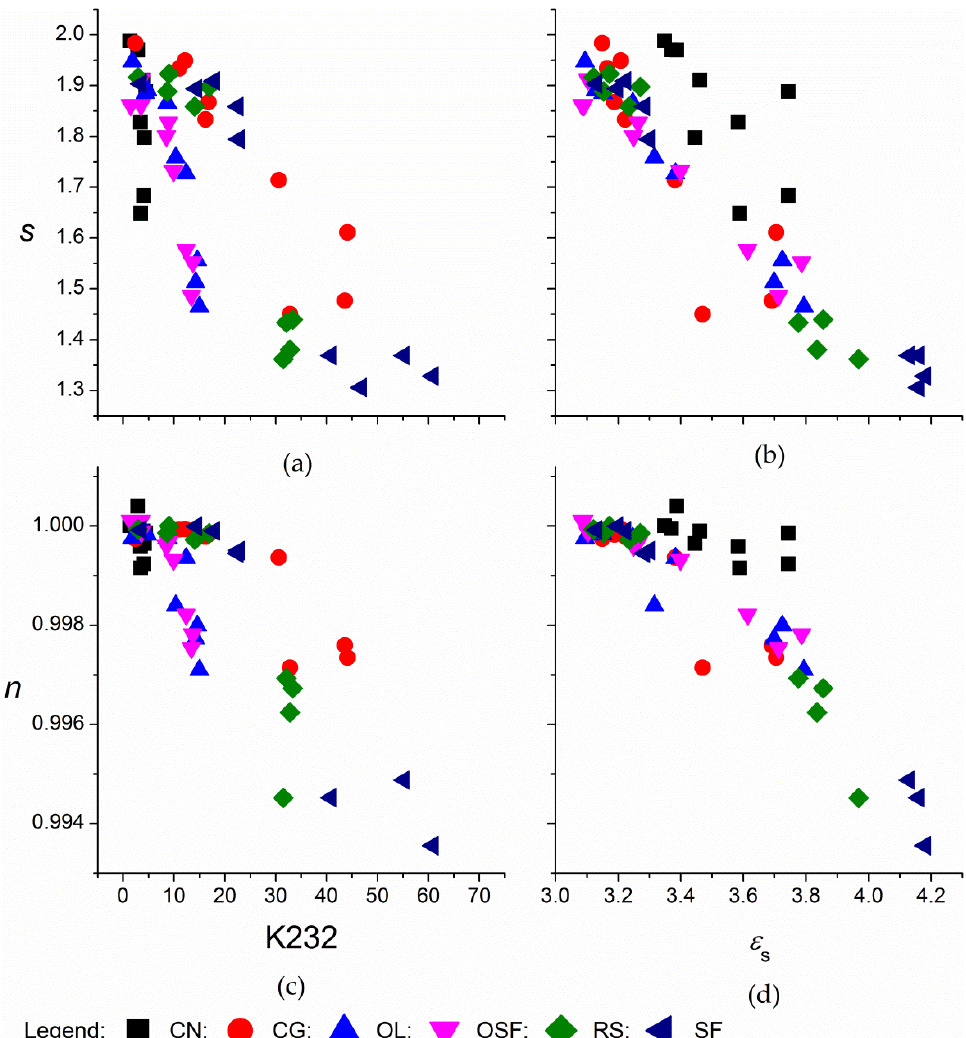
Figure 3. Dependence of exponents s from Equation (9) ( a , b ) and n from Equation (11) ( c , d ) on the sum of the specific absorption coefficient K232 ( a , c ) and the dielectric constant, ε s ( b , d ) for the edible oils thermally treated at 180 °C. CN, coconut oil; CG, corn-germ oil; OL, olive oil; RS, rapeseed oil; SF, sunflower oil; and OSF, high oleic acid sunflower.